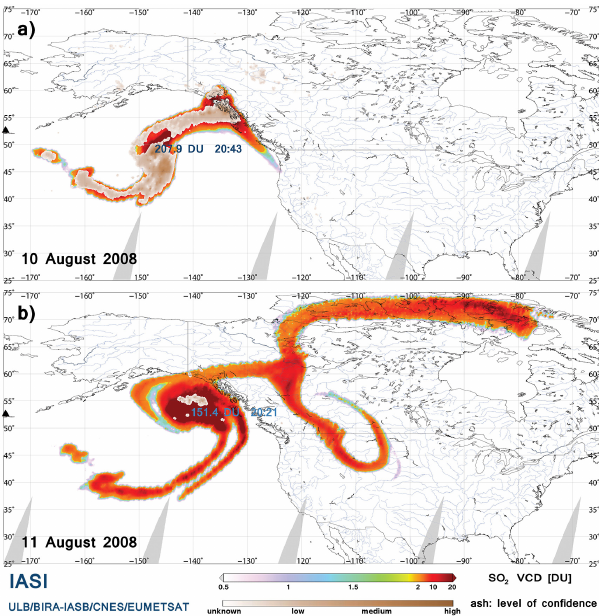
Fig. 16. IASI-A SO 2 column density and ash index emitted by the Kasatochi Volcano on (a) 10 August 2008, and (b) 11 August